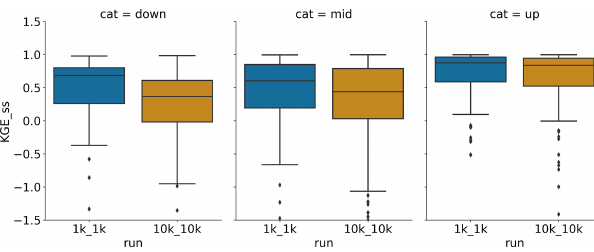
Figure 3. Box plots of obtained KGE ss values for all stations cate- gorized as downstream, midstream, and upstream for selected runs.